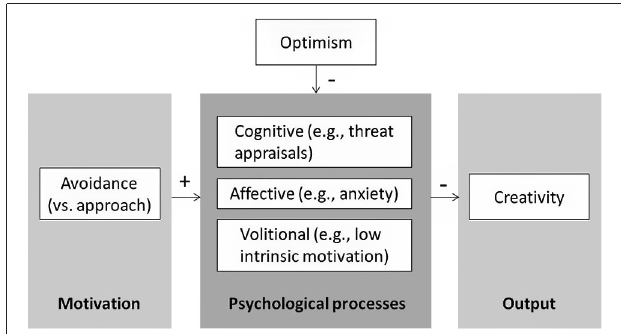
FIGURE 1 | By influencing the psychological processes that are evoked by avoidance motivation, optimism reduces the undermining effect of avoidance motivation on